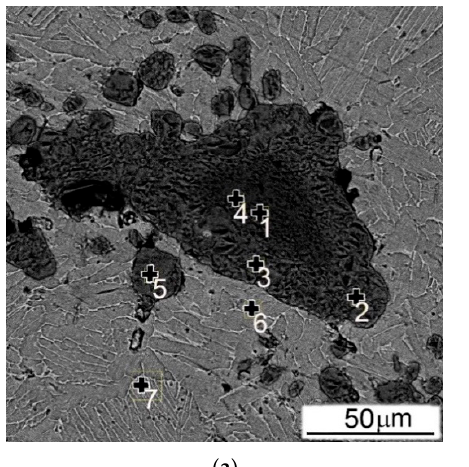
Figure 22. Schematic illustration of the stress concentration mechanisms involving pores ( a , d ), carbides ( b , e ), and borides ( c , f ) under tensile ( a – c ) and compression ( d – f ) test.